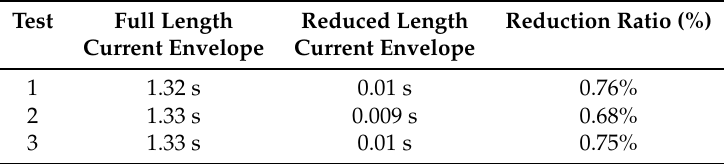
Figure 6. Test 3. Motor fed directly from the mains, and rated load (speed = 2892 r/min slip = 0.0359 p.u.). ( a ) Full-length current envelope (10 7 samples) and its spectrum ( b ), showing the three first fault harmonics. ( c ) Reduced current envelope (10,000 samples), and its spectrum ( d ). Both spectra show the same fault harmonics, although the reduced current envelope contains only the 0.1% of the original number of samples. Table 3. Comparison between the time (seconds) needed to compute the power spectrum of the full-length current envelope and of the reduced current envelope proposed in this